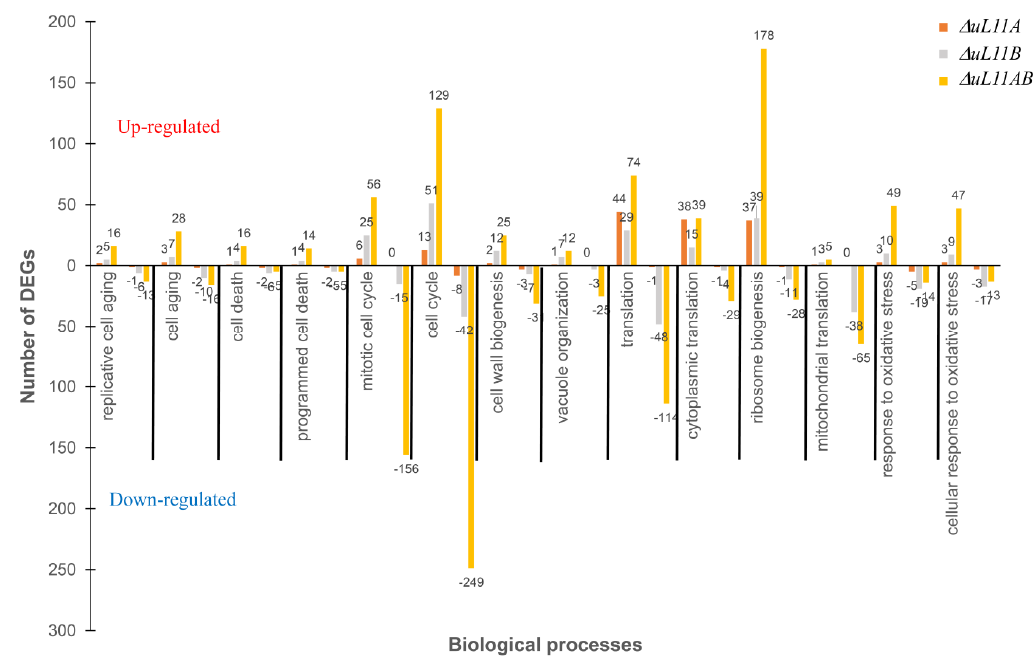
Figure 9. Gene Ontology (GO) enrichment of DEGs. GO enrichment of up- and downregulated DEGs were performed using biological process classification. The GO term was considered enriched significantly when the p values of Fisher’s exact test were <